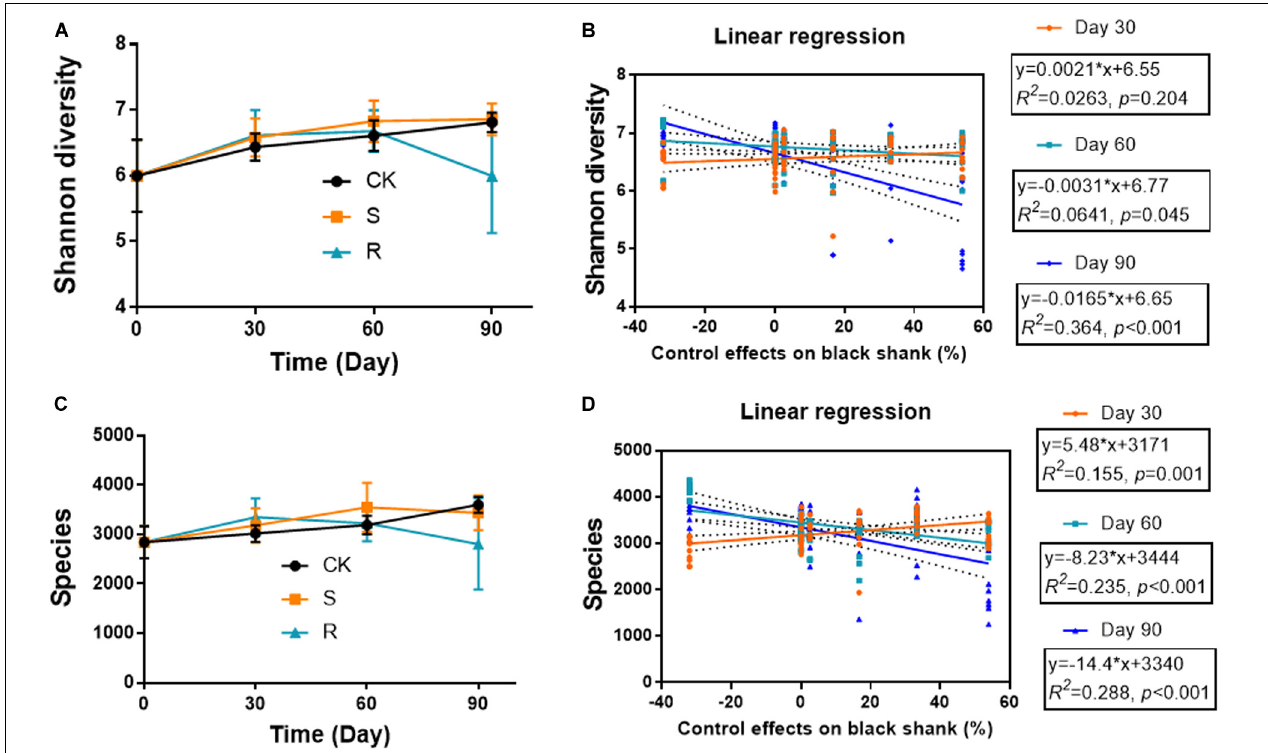
FIGURE 3 | Temporal variations in (A) Shannon diversity and (C) species diversity; relationships between (B) Shannon diversity and suppression of black shank, and (D) species diversity and disease suppression (D) . CK, control group; R, treatment with root functional microflora; S, treatment with soil functional microflora.